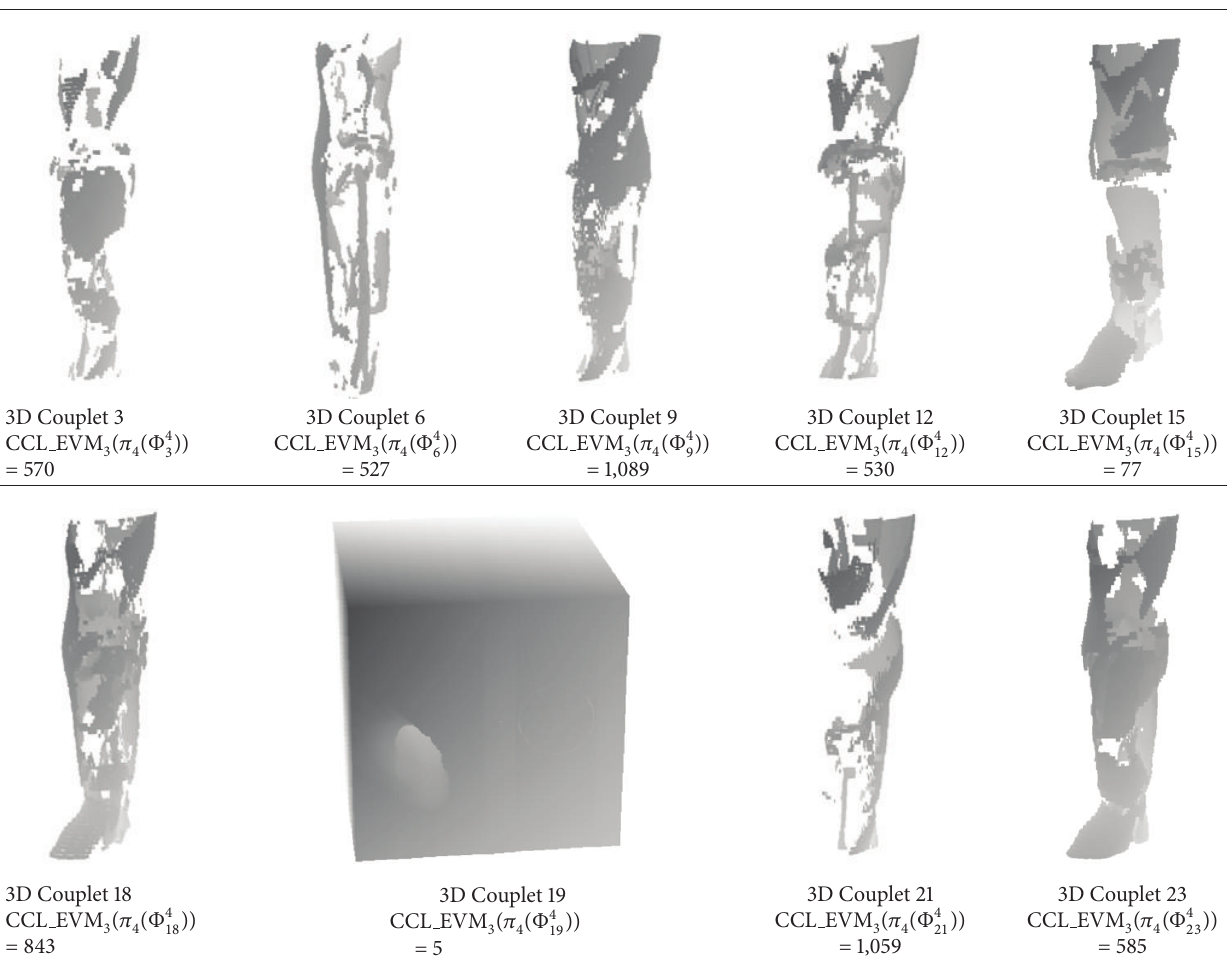
Table 12: Some 3D couplets, perpendicular to color axis, extracted from the 4D-EVM produced by means of Framework 𝑛 D-EVM/Kohonen and associated to dataset Statue Leg